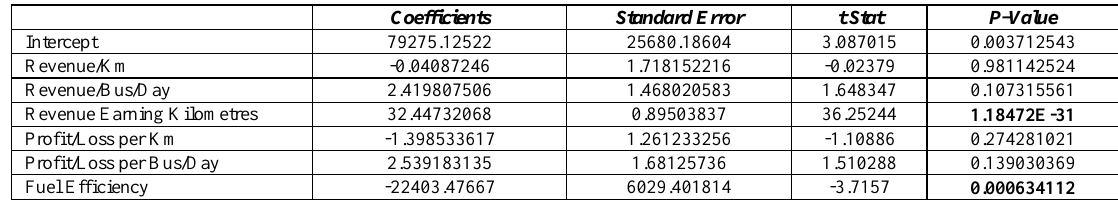
Table 8. Regression analysis for total